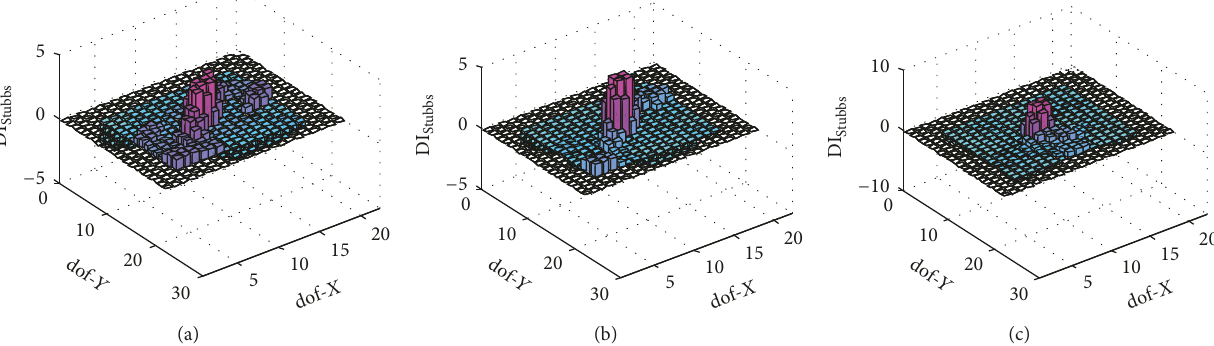
Figure 6: Effect of the noise in DI Stubbs calculated for DS3 versus DS0 for a 16-dof model. (a) 0% noise, (b) 5% noise, and (c) 10% noise.